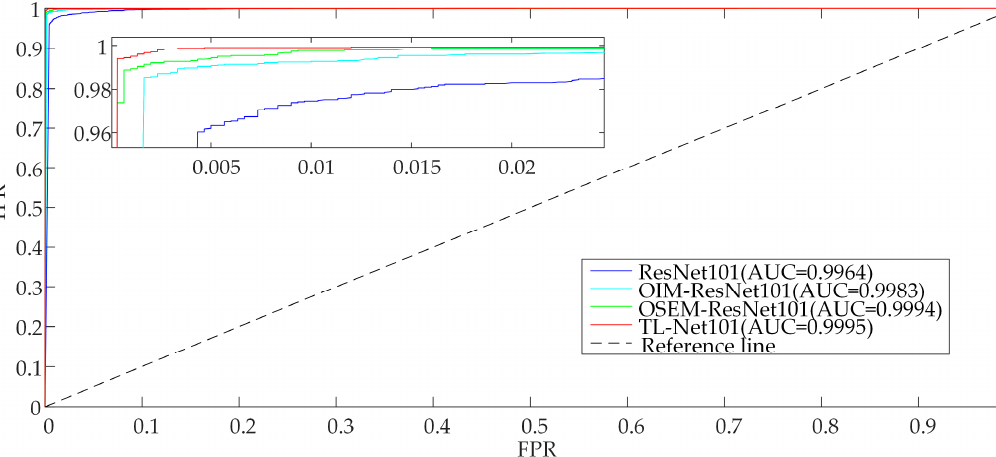
Figure 10. The ROC curves of ResNet101, OIM-ResNet101, OSEM-ResNet101, and TL-Net101.